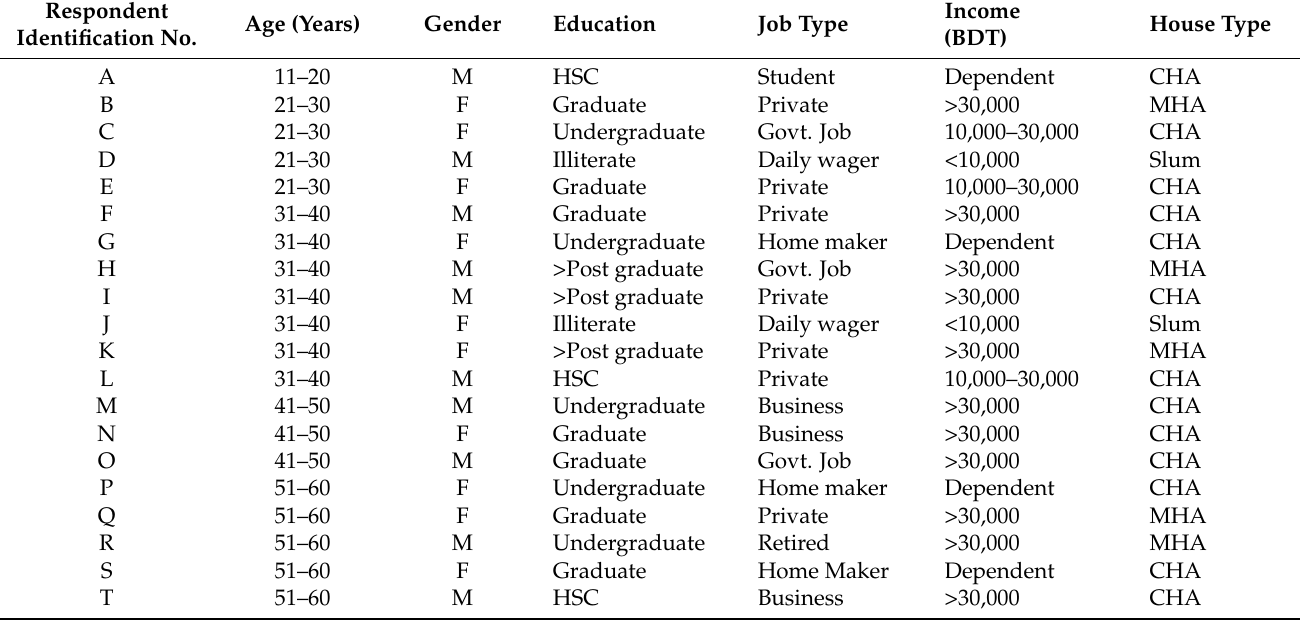
Table 2. Participant list for in-depth-interview selected based on socio-demographic characteristics from the online and face-to-face survey